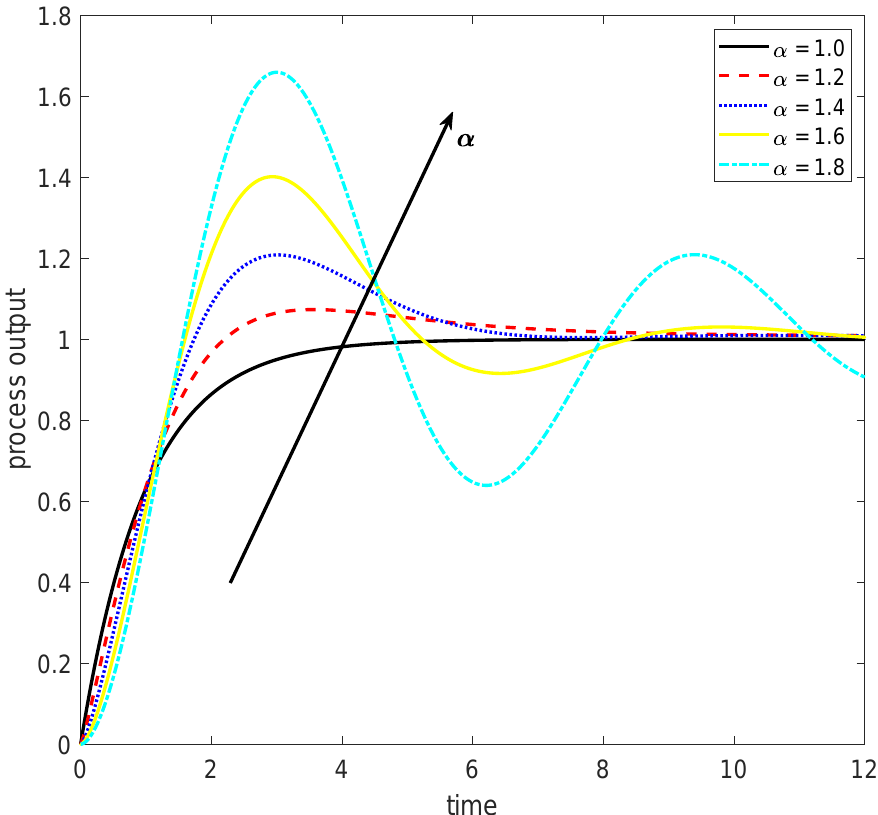
Figure 2. Step responses of the fractional system for α ∈ [ 1.0,1.8 ]